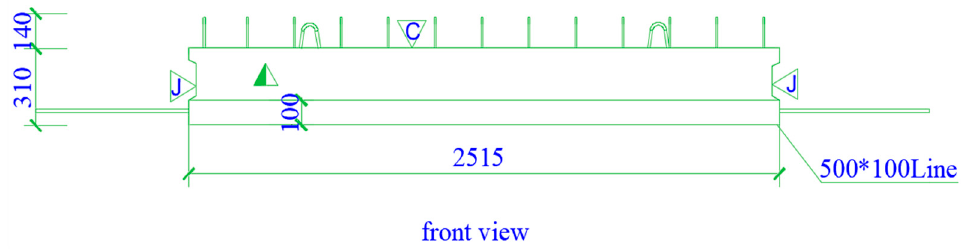
Figure 6. Front view of CG-2 composite beam.